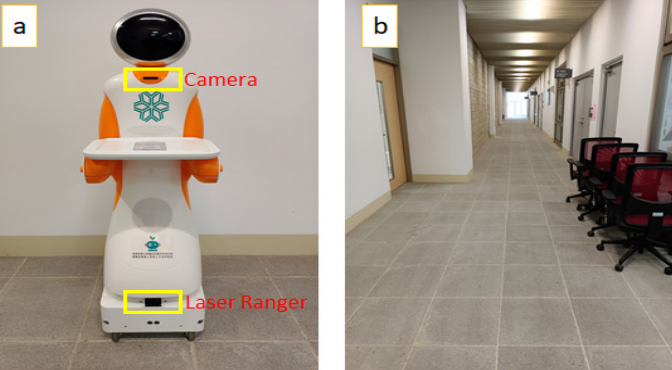
Figure 17. The actual mobile robot and experiment field. ( a ) An experimental service robot equipped with laser ranger and depth camera for detecting obstacle, ( b ) a long and narrow walkway for the field test.